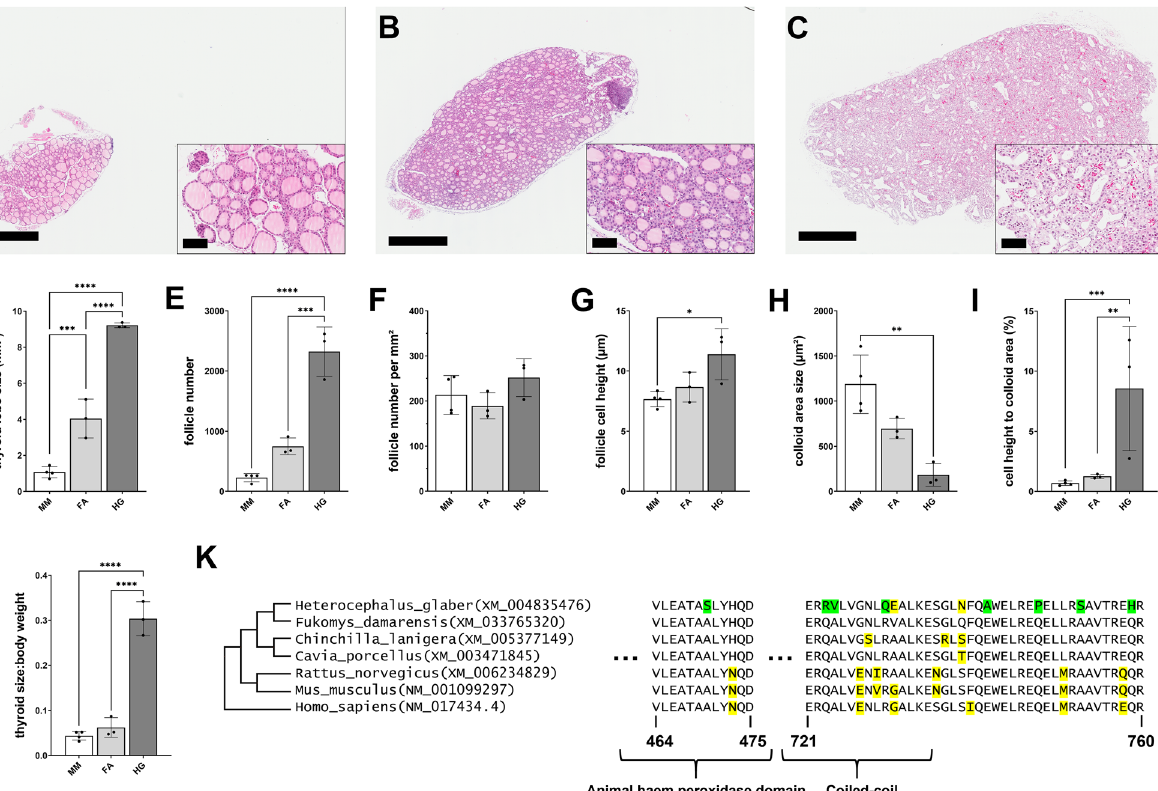
Figure 2. Thyroid gland morphology of mice, Ansell’s mole-rats, and naked mole-rats. HE-stained thyroid gland sections of ( A ) mouse, ( B ) Ansell’s mole-rat, and ( C ) naked mole-rat. Comparison of different thyroid gland parameters of mice, Ansell’s mole-rats, and naked mole-rats ( D – J ). ( K ) Protein-level alignment of DUOX1 displaying one site with high probability for positive selection (left, 96%) and seven sites with high selection probability > 50% in close proximity (right). Green marks sites predicted to be under positive selection in naked mole-rat, yellow marks other amino acids deviating from the consensus. Displayed coordinates refer to human. Domain information was taken from PFAM 50 . Normal distributed data were compared with one-way ANOVA followed by Tukey correction. Not normally distributed data were log-transformed prior to analysis with one- way ANOVA. p < 0.05 (*), p < 0.01 (**), p < 0.001 (***), p < 0.0001 (****). Data are presented as mean ± SD. Scale bars: 800 µm (large image), 90 µm (inlay). MM, Mus musculus ; FA, Fukomys anselli ; HG, Heterocephalus glaber